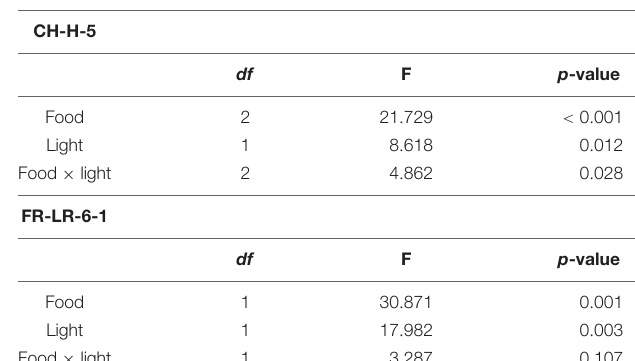
TABLE 2 | Results of the two-way ANOVA for the somatic growth rates of clones “CH-H-5” and “FR-LR-6-1” on different food treatments and in control or ALAN light conditions ( df = degrees of